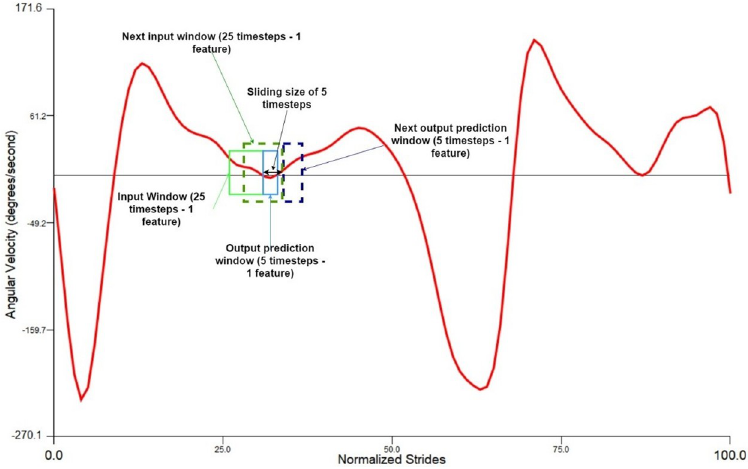
Fig 3. Sliding window demonstration on 1 feature. The graph shows the sliding window operation on the foot angular velocity ( X 1 ). In this paper, the input/output window comprises of 6